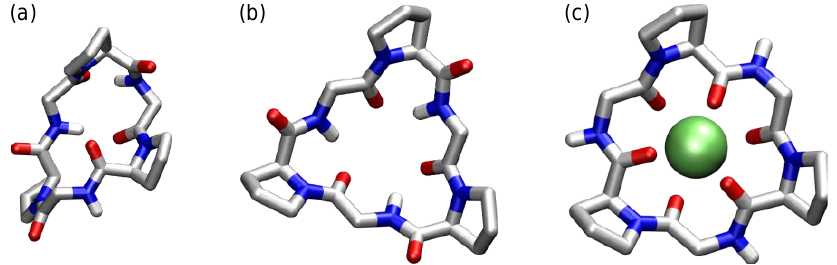
Figure 1. Calculated structures of the preferred conformation of 1a in polar solvents ( a ), in nonpolar solvents ( b ), and structure of the 1:1 complex with Ca 2+ ( c ). The calculations were performed by the author of this review based on the reported results by using Spartan 20 (Wavefunction, Inc., Irvine, CA, USA) and the MMFF force-field (see Supporting Information). Protons, except acidic ones, are omitted for reasons of clarity. For the proposed 2:1 structure of the Mg 2+ complex, no C 3 symmetric structure could be obtained.